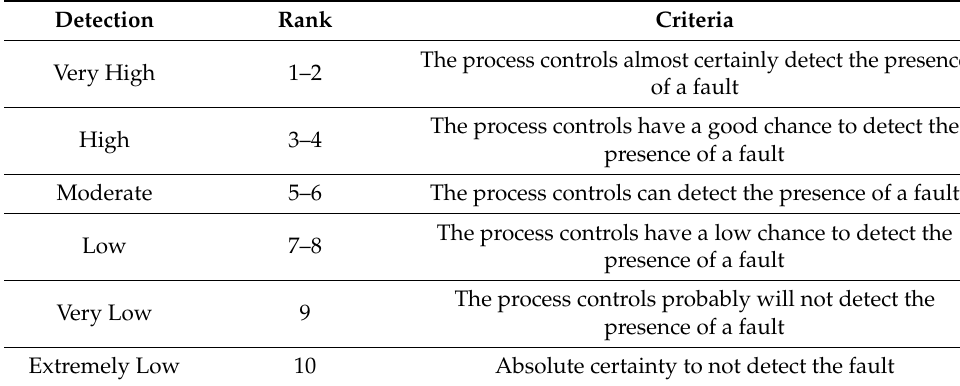
Table 5. Ratings for the detection of a failure mode.